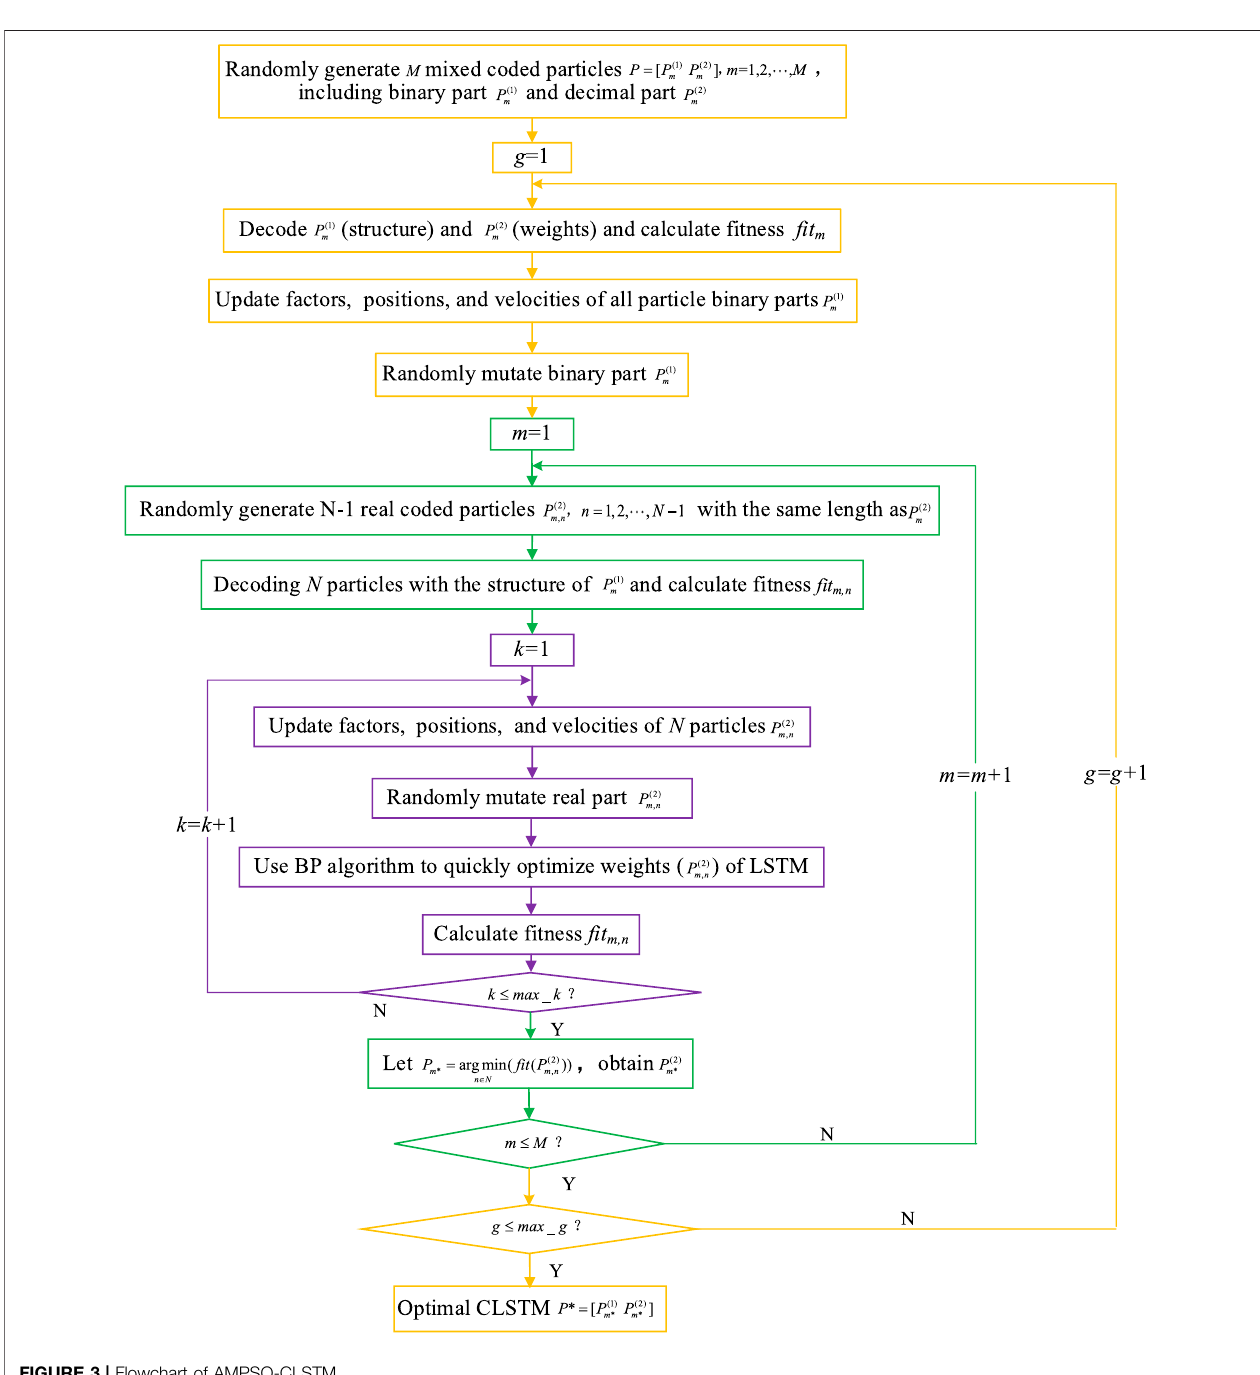
FIGURE 3 | Flowchart of